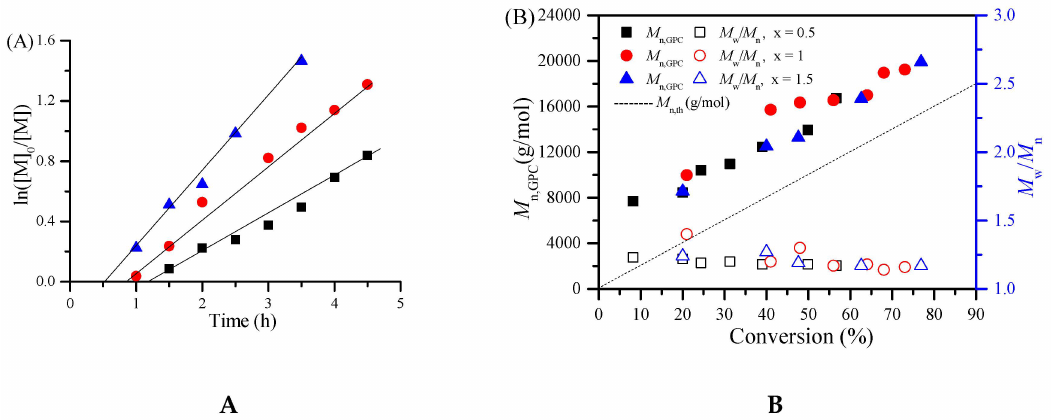
Figure 2. ln([M] 0 /[M]) as a function of time ( A ) and evolution of number-average molecular weight ( M n,GPC ) and molecular weight distribution ( M w / M n ) versus conversion ( B ) for ICAR ATRP of MMA with various ACHN concentration. Polymerization conditions: [MMA] 0 :[EBPA] 0 :[Fe(acac) 3 ] 0 :[PPh 3 ] 0 :[ACHN] 0 = 200:1:0.02:0.3: x ( x = 0.5, 1, 1.5), V MMA = 1.0 mL, V toluene = 1.0 mL, T = 90 ˝